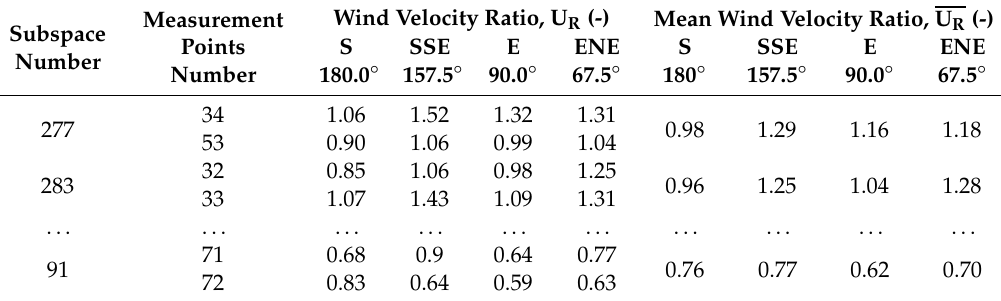
Table 5. Mean wind velocity ratio (U R ) calculation results ( ... stands for ellipsis). Measurement Subspace Number